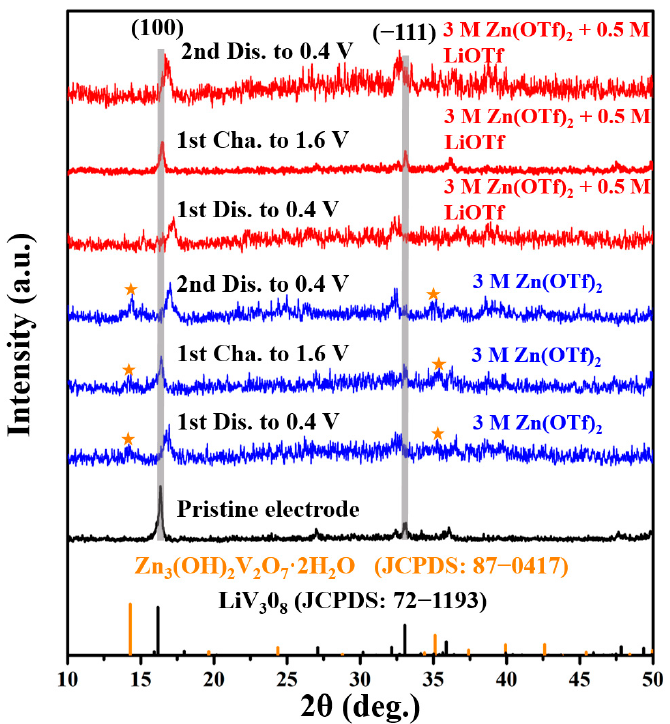
Figure 5. Ex-situ XRD patterns of the LiV 3 O 8 electrodes at different charge/discharge states.